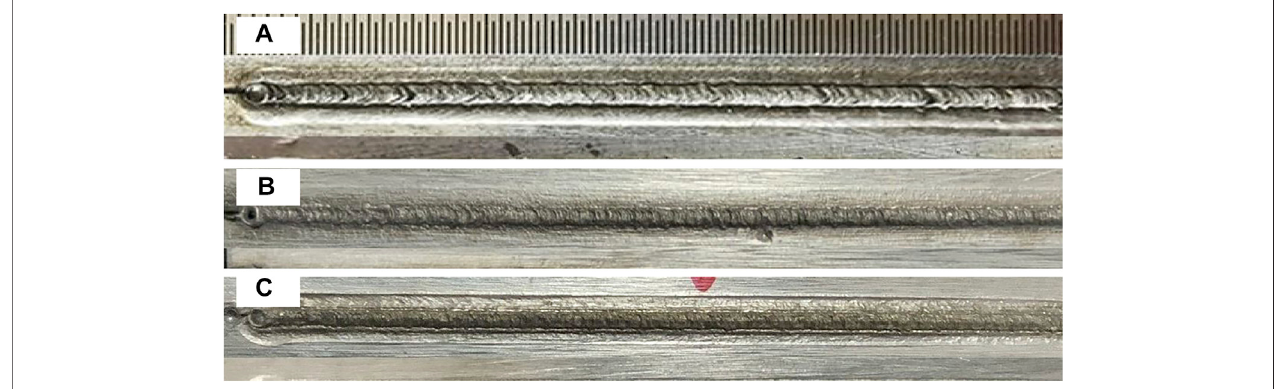
FIGURE 4 | Surfaces morphologies of welds obtained by different welding processes, (A) direct laser welding (B) laser welding with Ti interlayer (C) Ultrasonic- assisted laser welding with Ti interlayer.